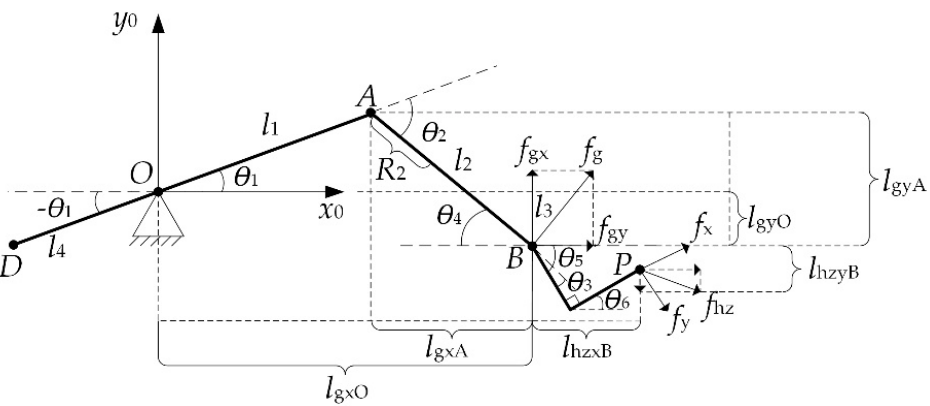
Figure 6. End applied force model.